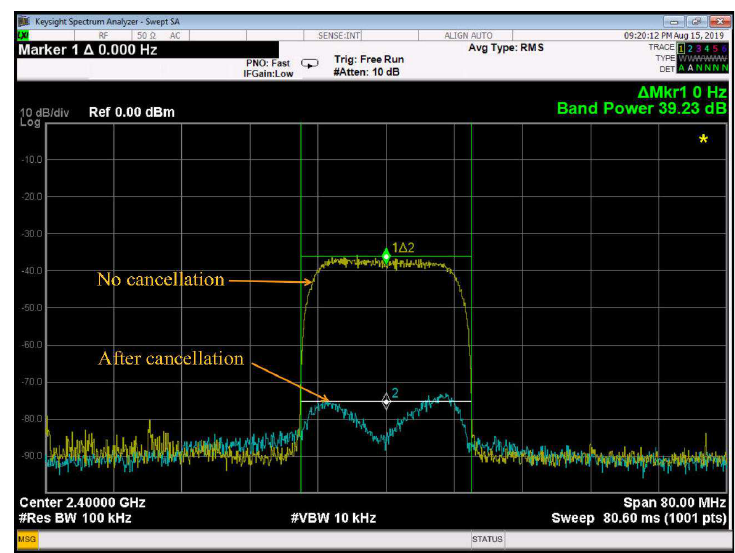
Figure 7. Measurement results for 20 MHz bandwidth.